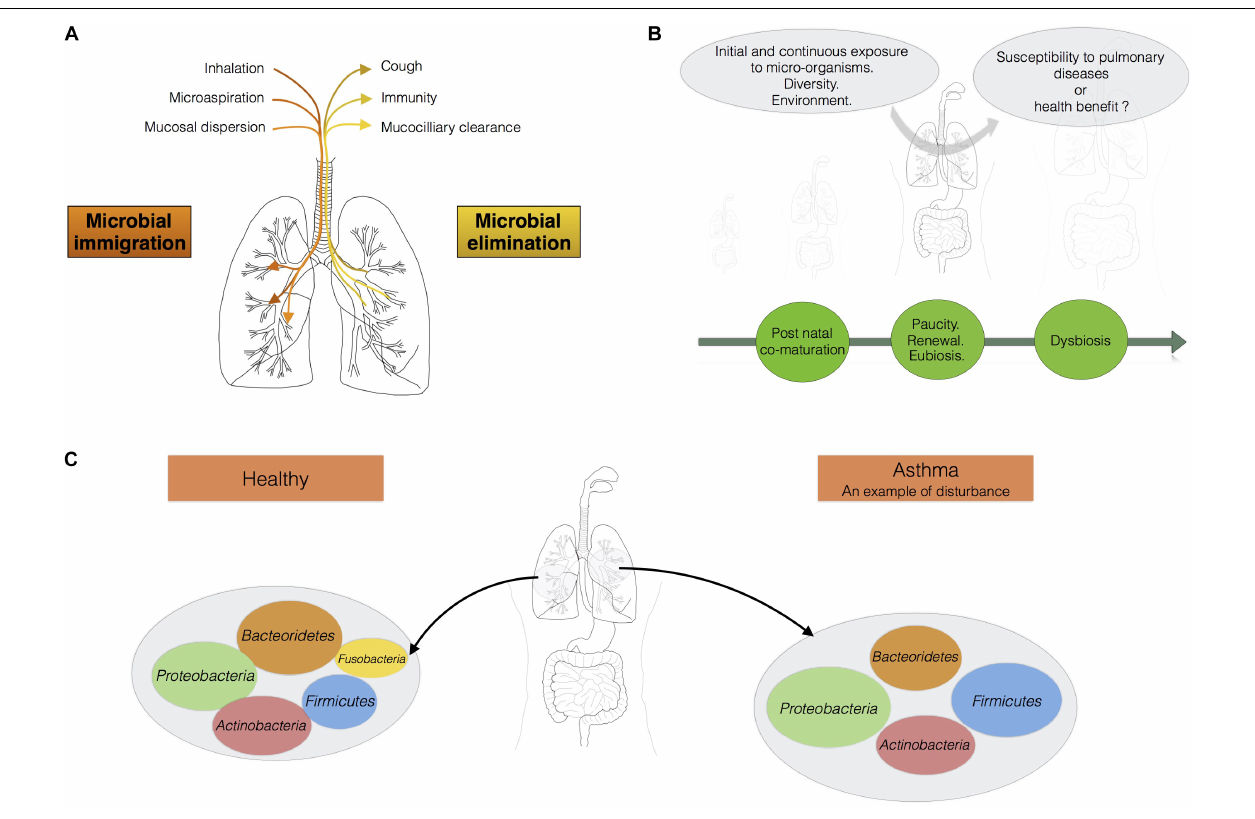
FIGURE 1 | The lungs should be considered as an ecosystem with its own microbiota. (A) Maintenance of balance in the lung microbiota: the communities of micro-organisms in the lungs are shaped by microbial immigration and elimination [adapted from (Dickson et al., 2014)]. (B) From birth onwards, the lungs are continually exposed to diverse micro-organisms. This diversity of bacterial exposure, the environment and any treatments administered may play a fundamental role in determining susceptibility to pulmonary disease. (C) In a healthy individual, the load of micro-organisms in the lungs is equivalent to 10 3 –10 5 bacteria per gram. Proteobacteria, Firmicutes, and Bacteroidetes are the main phyla present. Asthma is associated with a shift in the lung microbiota toward greater diversity and species